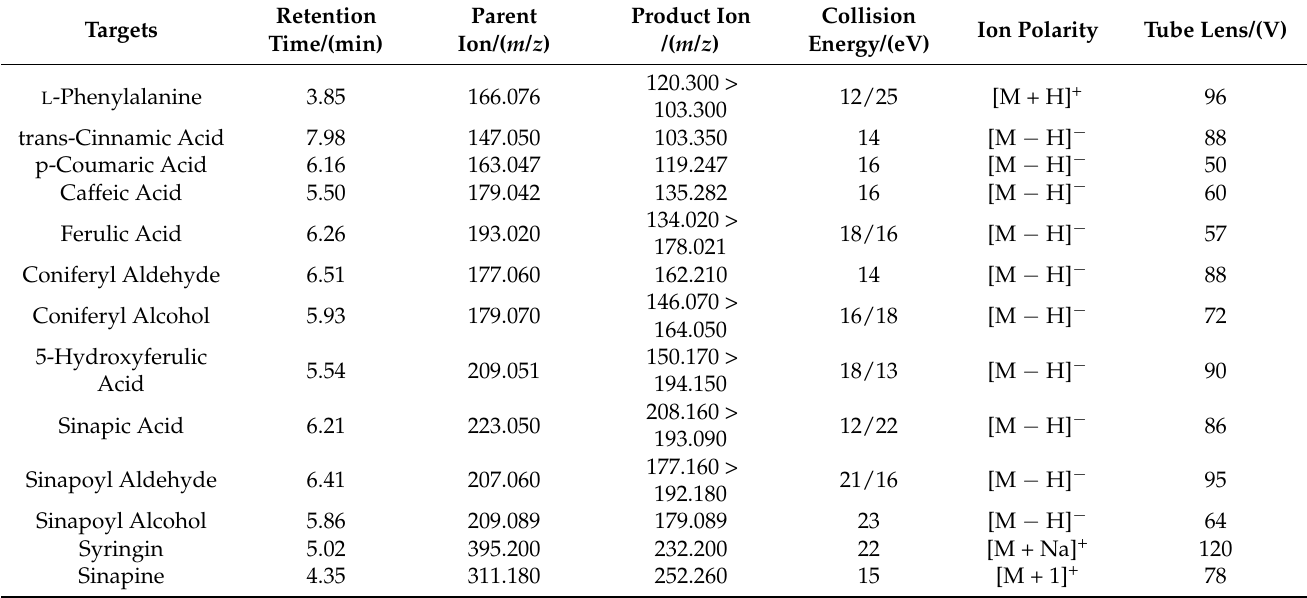
Table 2. Retention time and scan parameters of target